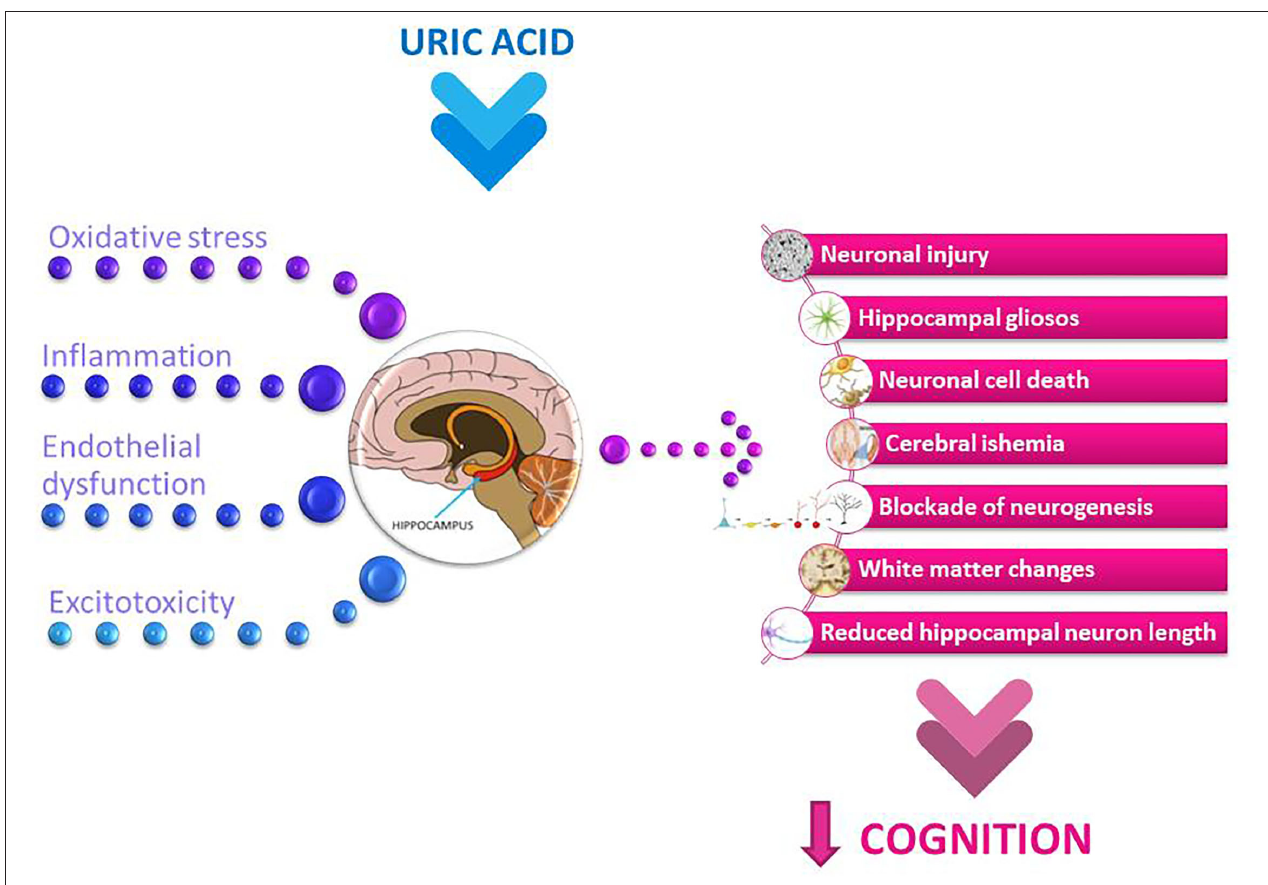
FIGURE 2 | Potential mechanisms involved in uric acid-related cognitive dysfunction. The summary of the main pathological mechanisms of uric acid, such as oxidative stress and neuroinflammation, along with endothelial dysfunction and excitotoxicity, which may collectively affect neuronal and brain function and further implicate uric acid-related cognitive